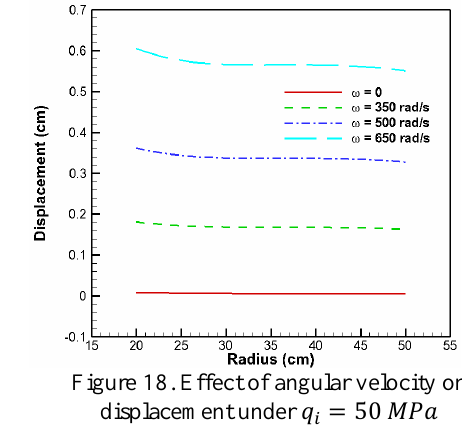
Figure 18. Effect of angular velocity on displacement under 𝑞